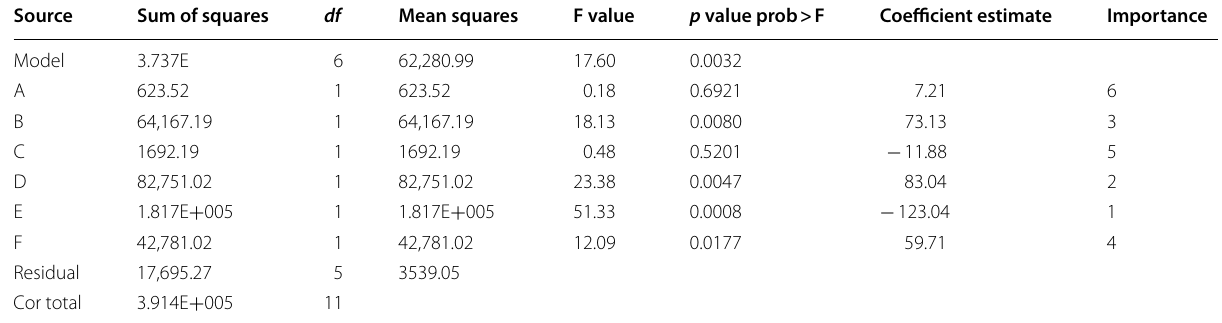
Table 3 Analysis of variance in Plackett–Burman Source Sum of squares